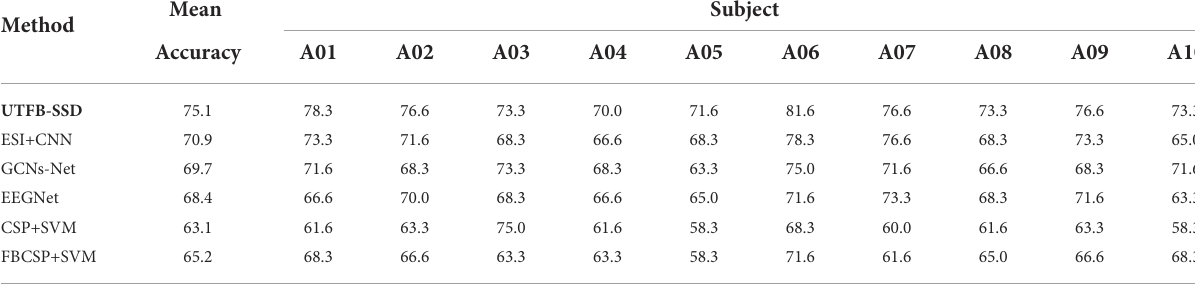
TABLE 1 Comparison of the accuracies (%) between the proposed algorithm and other methods on the in-house dataset (without stimulation). Method